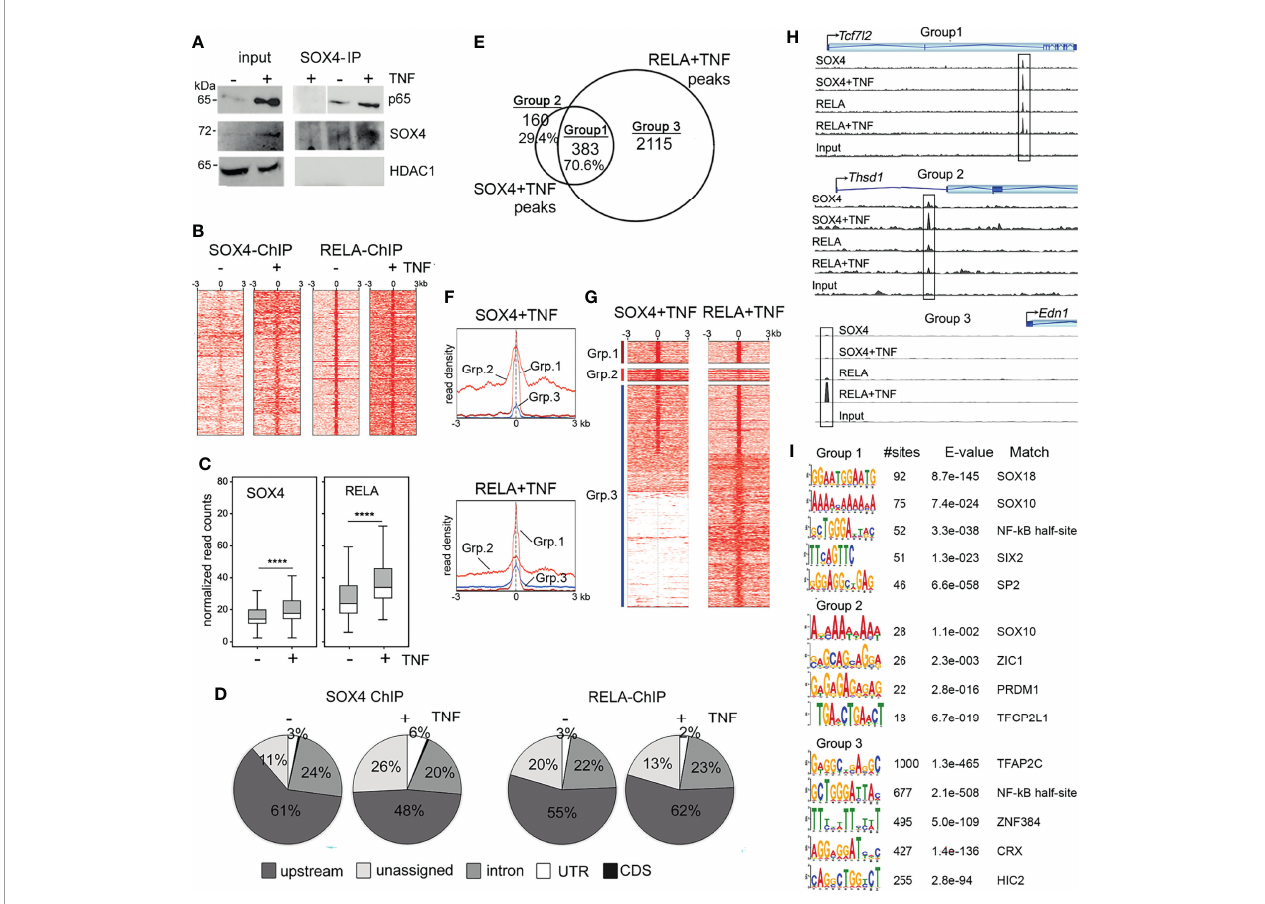
FIGURE 1 | SOX4 and RELA interact on the chromatin (A) Immunoprecipitation of nuclear extracts from wildtype FLS treated with or without 10ng/mL TNF for 16 h. Western blot showing lysates and immunoprecipitates detected with the indicated antibodies. (B) Heatmap of the read coverage density (more red means more reads at that location) around the transcription start site (TSS) in wildtype FLS treated with or without TNF. (C) Box plot representation of normalized read counts in of SOX4 and RELA ChIP-seq peaks. ****p-value < 0.0001 (pairwise t-test adjusted by the Benjamini-Hochberg method). (D) Genome wide distribution of SOX4 and RELA ChIP-seq peaks in wildtype FLS treated with or without TNF. (E) Venn diagram showing overlap between SOX4 and RELA ChIP-seq peaks that are located within 50bp of each other. (F) TSS pro fi le plot and (G) Heatmap showing the pattern of binding at the overlapped locations identi fi ed by the Venn Diagram in (F) . The color bars on the left correspond to Venn Diagram grouping of peaks. (H) Genome tracks of SOX4 and RELA ChIP-seq peaks at the loci of representative examples of Group 1, 2 and 3 genes. (I) Enriched motifs in the RELA-SOX4 overlapping ChIP-seq peaks in TNF-treated